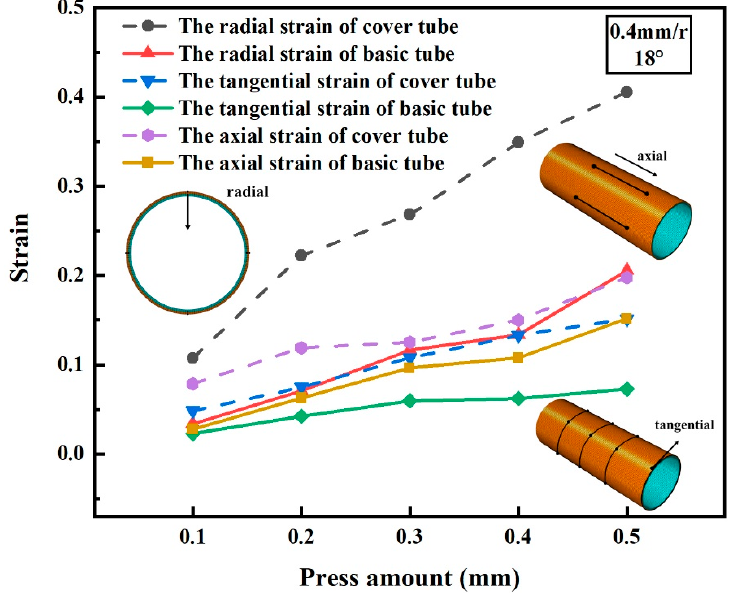
Figure 8. Three-way strain distribution for basic and cover tubes with di ff erent press amounts.